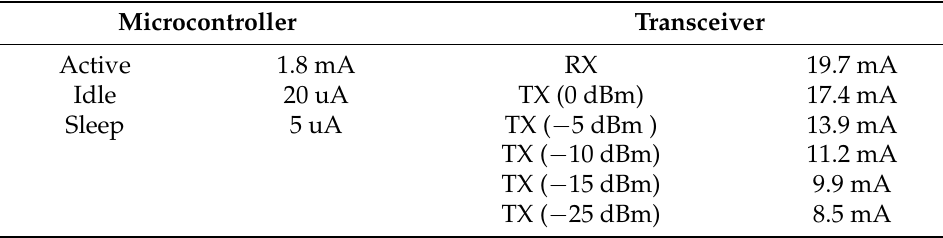
Table 2. MICAz mote current